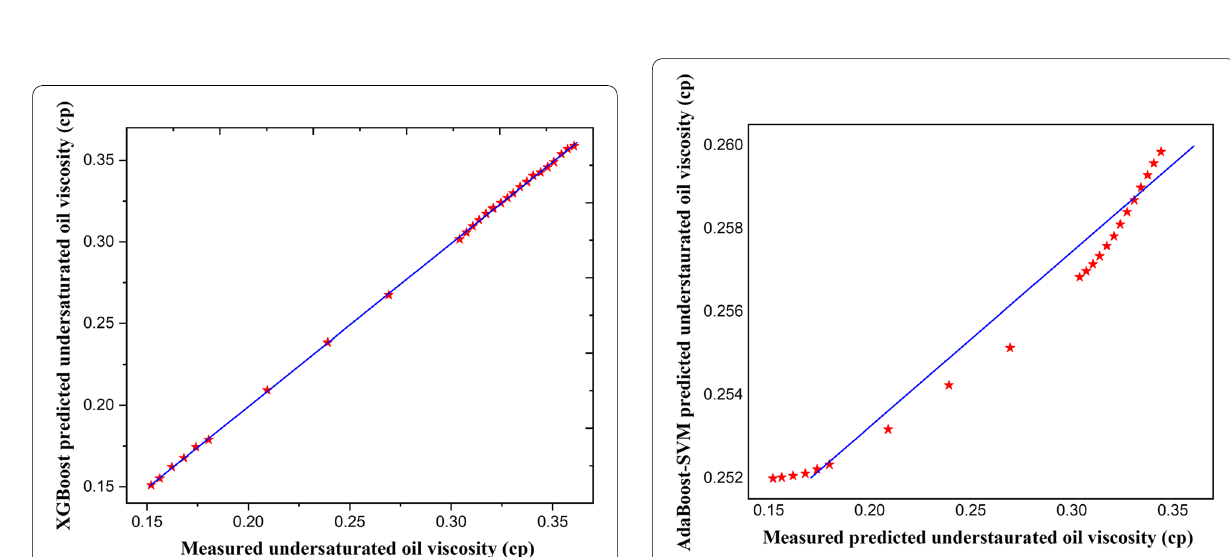
Fig. 15 Cross plot of XGBoost predicted values versus measured values